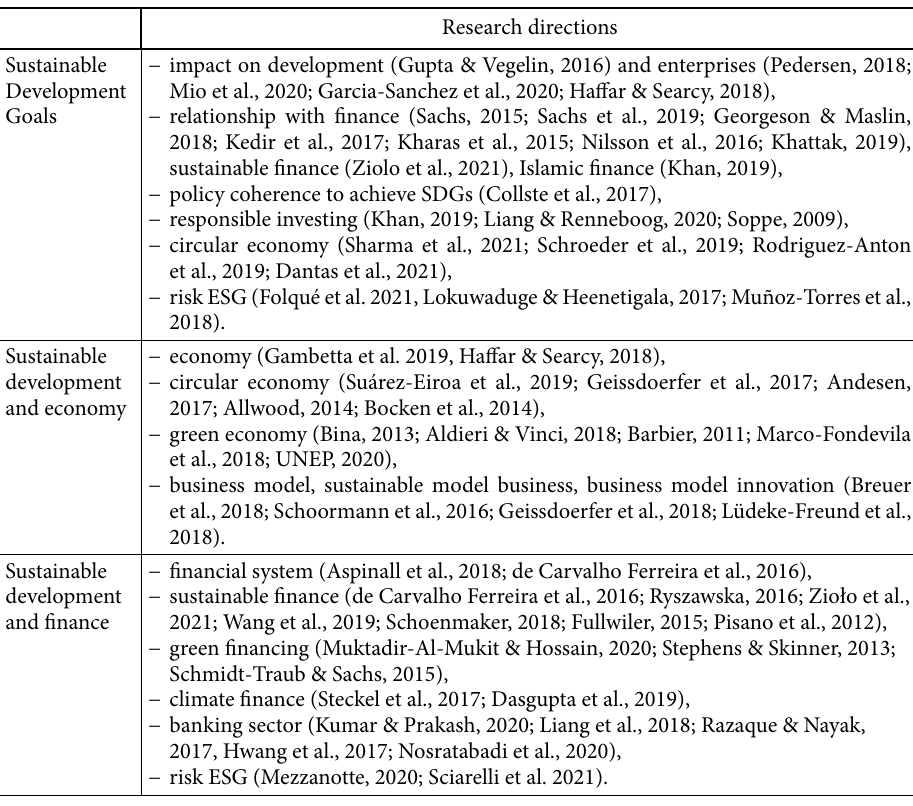
Table 1. Research directions in the field of sustainable development